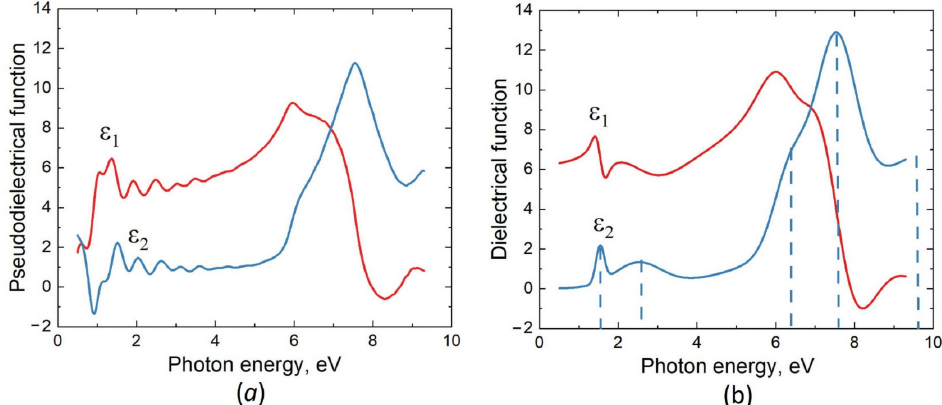
Figure 2. Pseudodielectric function of a 3C–SiC sample grown by MCSA on the p-type Si(111), as measured with the VUV-VASE ellipsometer ( a ), and dielectric function of the sample, as extracted from the measured data ( b ). ε 1 is the real part and ε 2 is the imaginary part; the dashed lines show the positions of the peaks of the ε 2 function.